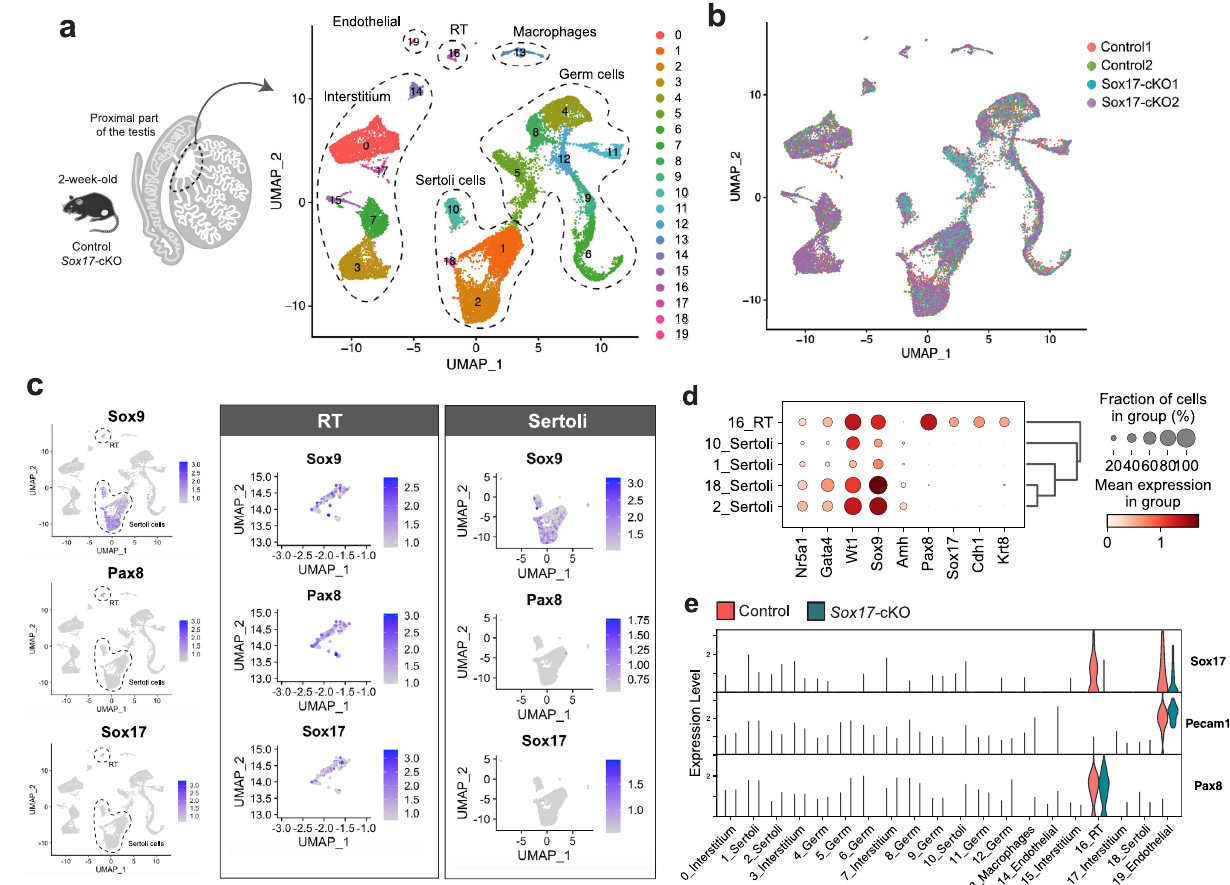
Fig. 3 | Molecular characterization of the testis of Sox17- cKO mice by scRNA- seq. a , b Schematic illustration of the experiment and Uniform Manifold Approx- imation and Projection (UMAP) plot of cells isolated from the proximal part of the testis of P14 Sox17- cKO and controls, showing twenty clusters ( a ) and the dis- tributionofcellsfromeachsample( b ).Control n =2, Sox17- cKO n =2. c UMAPplot showing the expression level of Sox9, Pax8, and Sox17 in the control samples. The right two panels show the expression of each gene in the extracted clusters of the